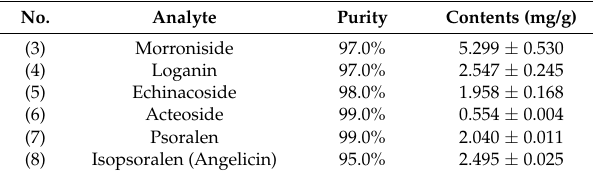
Table 1. Compounds contents of HBX-5.